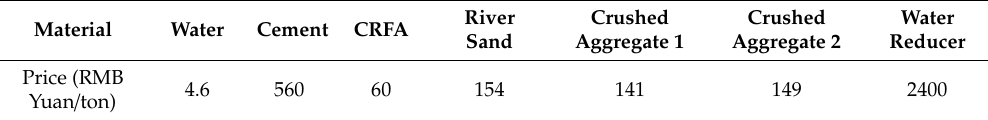
Table 10. The material prices in Guangzhou, China, in April 2020